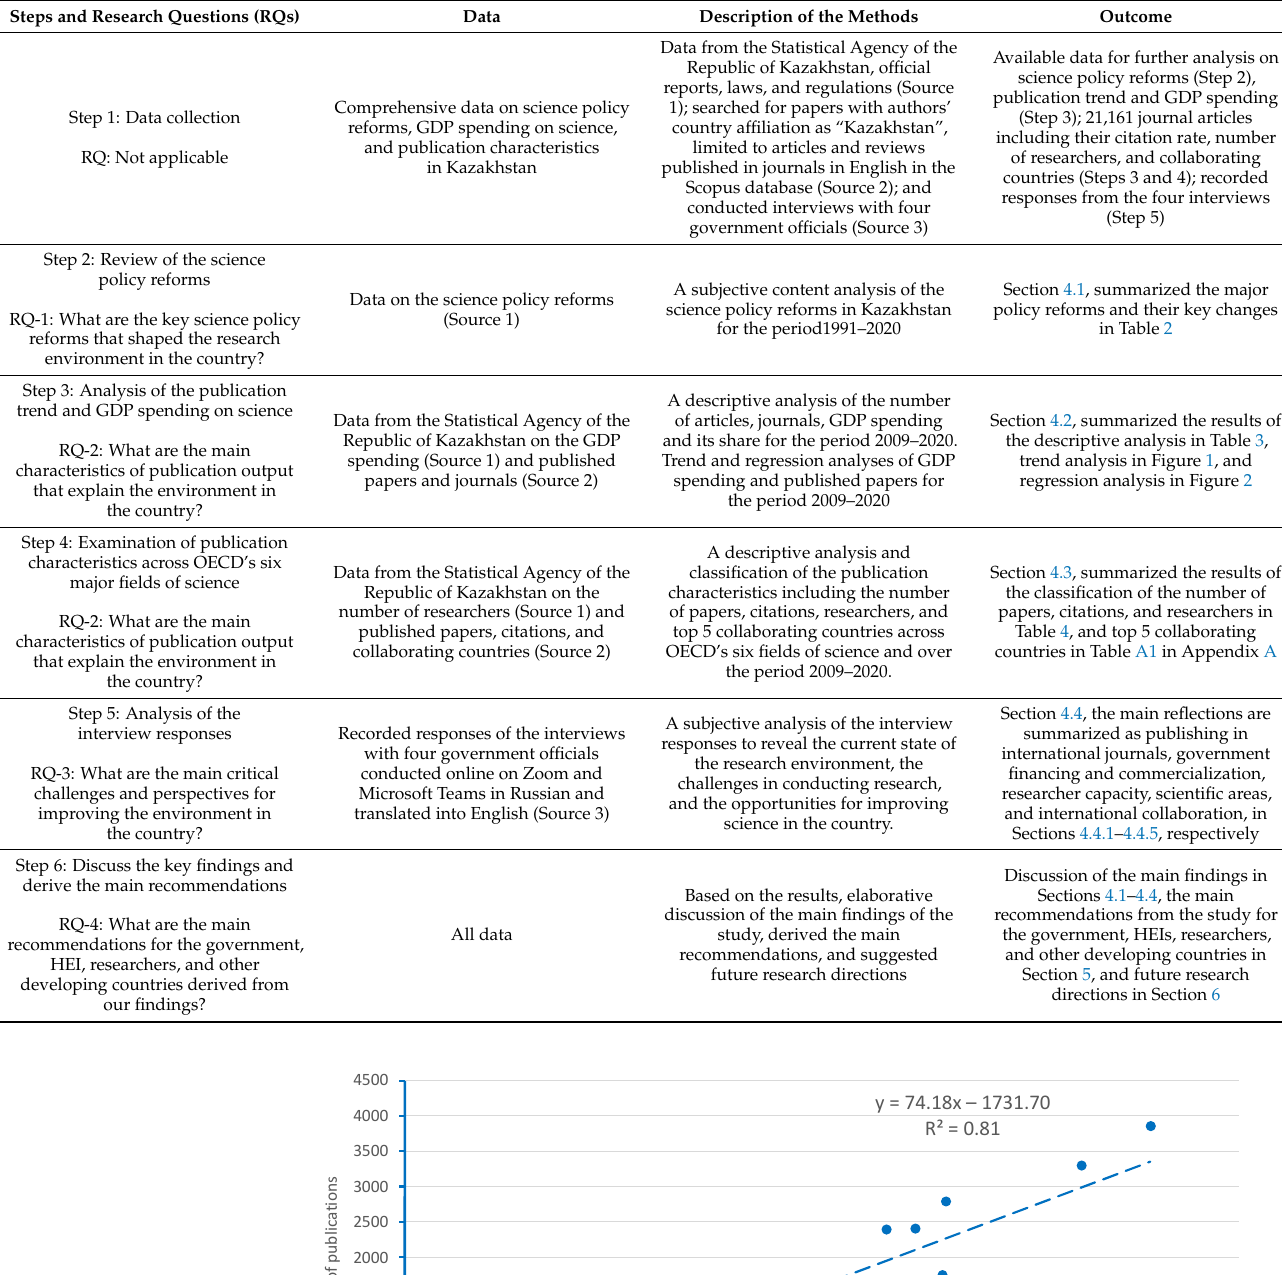
Table 1. The research approach of the current study.